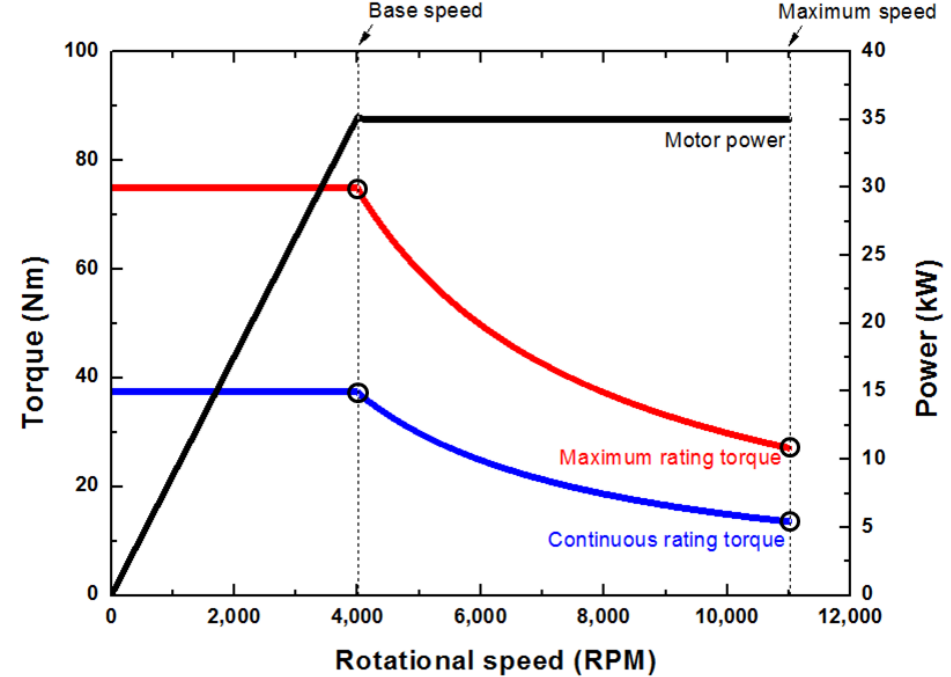
Figure 1. T-N curve of in-wheel motor